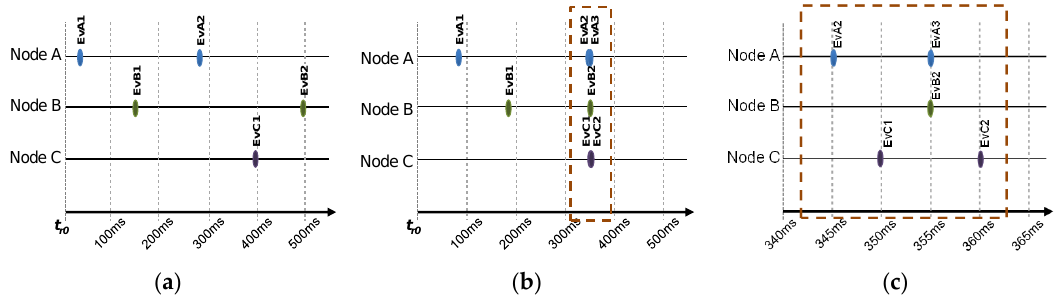
Figure 4. ( a ) Sparse event generation; ( b ) Almost simultaneous events; ( c ) Closer look to interval 300 ms–400 ms in ( b ), with higher precision.